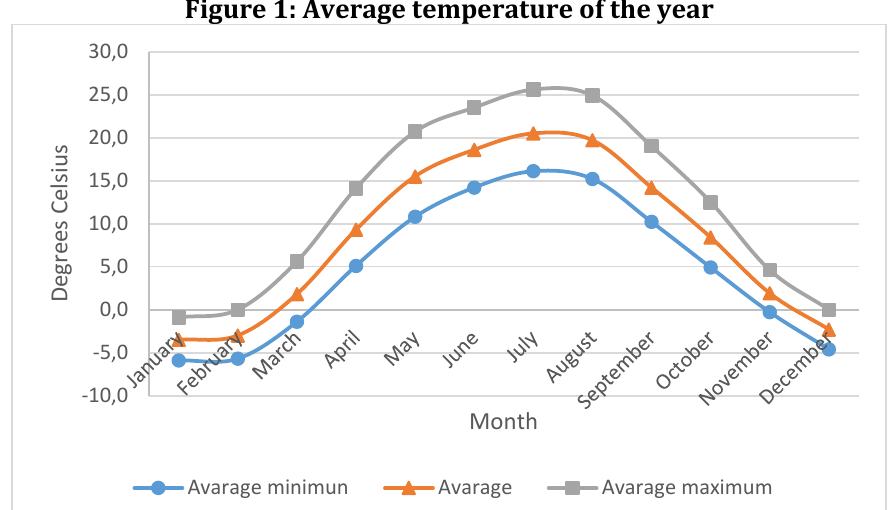
Source : based on (Climate in